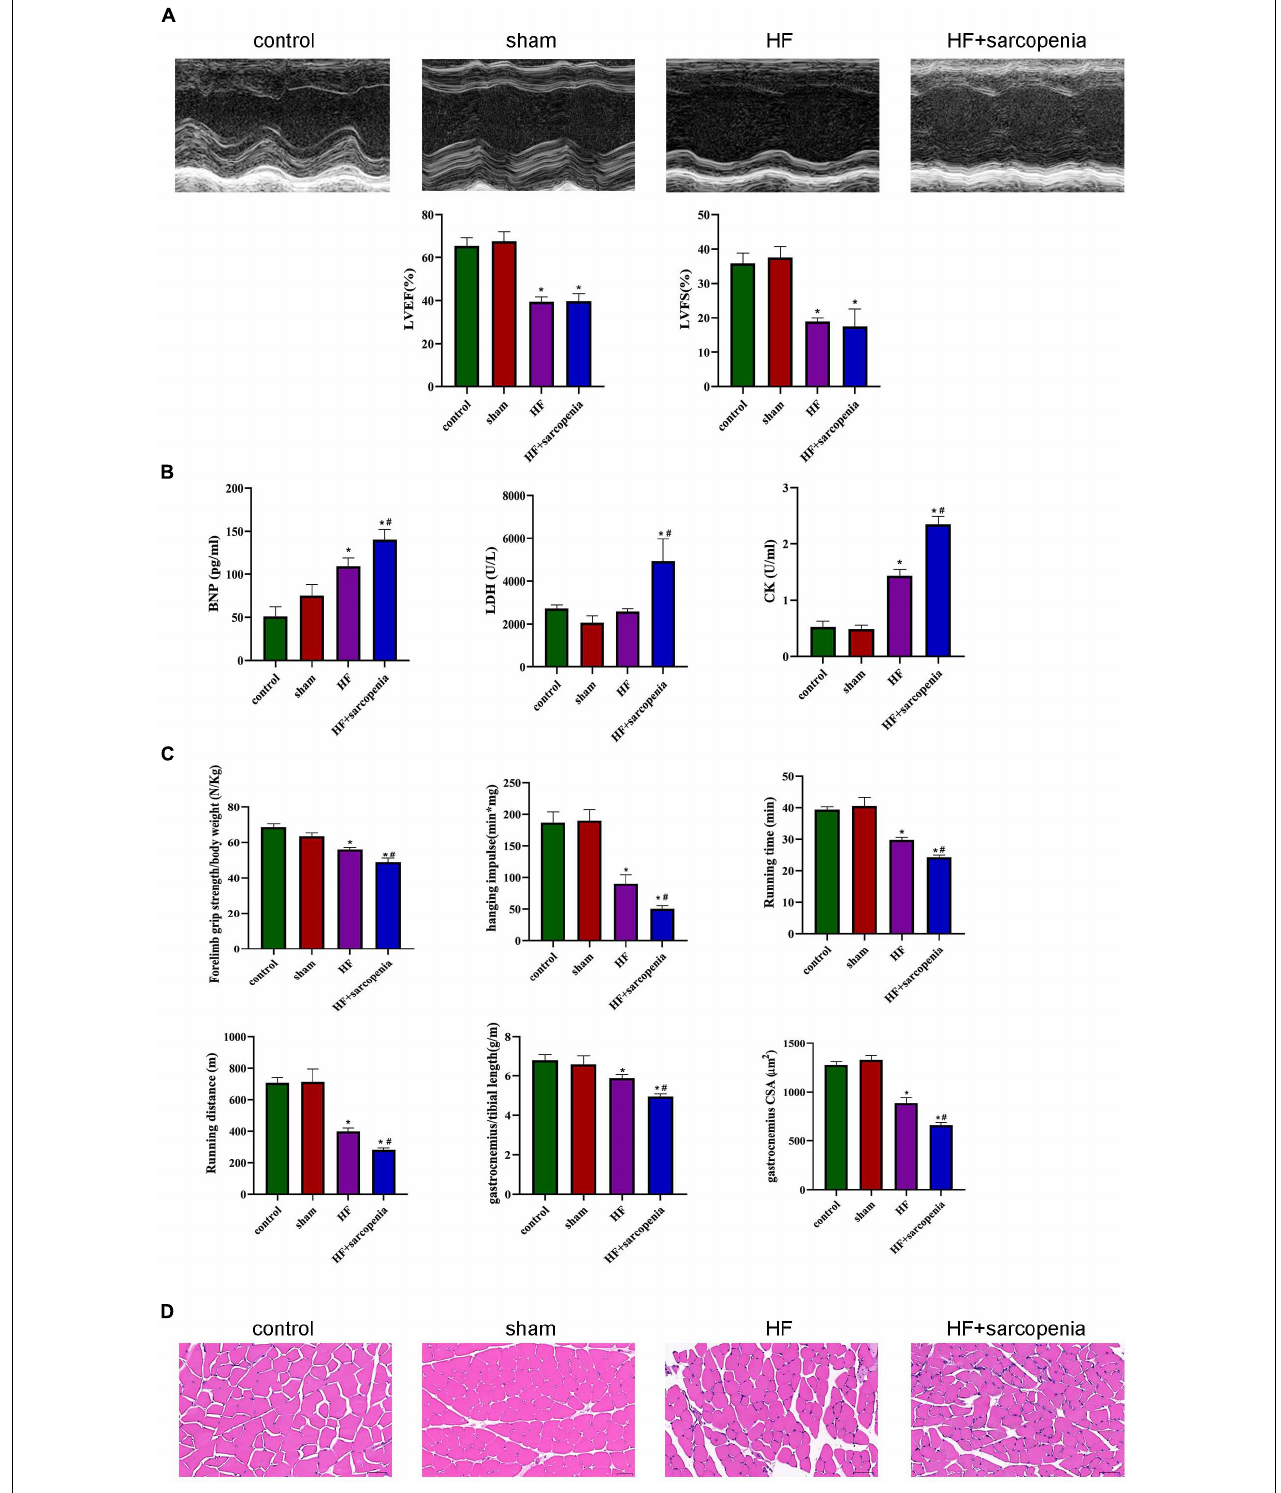
FIGURE 1 | Establishment of a model of heart failure with sarcopenia C57BL6/J mice were separated into control, sham, HF, HF + sarcopenia group. (A) Echocardiography: LVEF (%) and LVFS (%). (B) Serum BNP (pg/mL), LDH (U/L), CK level (U/mL). (C) Exercise capacity detection: forelimb grip strength test, hanging grid test, exhaustive running test, and ratio of gastrocnemius weight to tibial length. (D) Hematoxylin-eosin (HE) staining and cross section area (CSA) of muscle fibers ( µ m 2 ). N = 5–12. * P < 0.05 vs. control, # P < 0.05 vs. HF. Bar = 40 µ m.